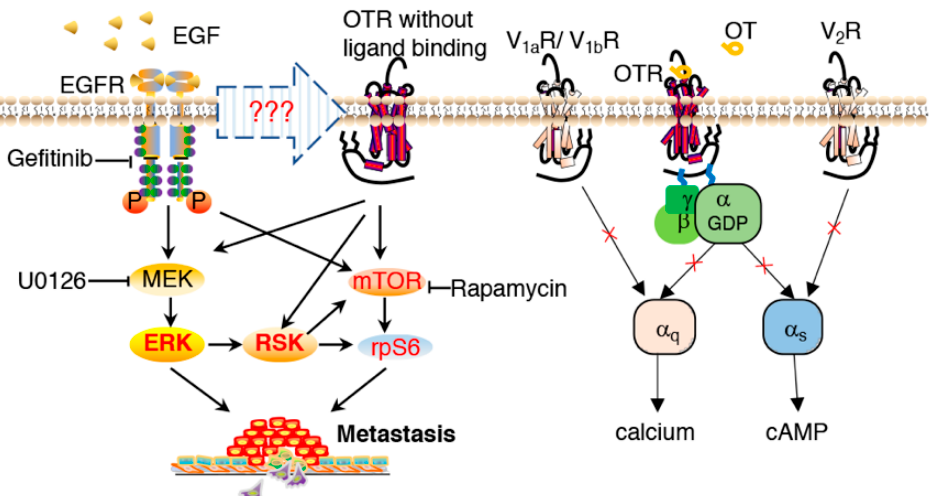
Figure 6. EGF ‐ mediated signal transduction involving the oxytocin receptor in promoting metasta ‐ Figure 6. EGF-mediated signal transduction involving the oxytocin receptor in promoting metas- sis. Normal OT/OTR signalling via G q or G s was compromised in MDA ‐ MB ‐ 231 cells. Involvement tasis. Normal OT/OTR signalling via G q or G s was compromised in MDA-MB-231 cells. Involve- of the V 1a R/V 1b R ‐ mediated G q pathway and V 2 R ‐ mediated G s pathway were excluded. In OTR ‐ over ‐ ment of the V 1a R/V 1b R-mediated G q pathway and V 2 R-mediated G s pathway were excluded. In expressing MDA ‐ MB ‐ 231 cells, EGF induced ERK1/2 ‐ RSK activation via both EGFR and OTR. The OTR-overexpressing MDA-MB-231 cells, EGF induced ERK1/2-RSK activation via both EGFR and mTOR pathway was also involved in EGF ‐ stimulated rpS6 activation, independent of ERK1/2 acti ‐ OTR. The mTOR pathway was also involved in EGF-stimulated rpS6 activation, independent of vation. ERK1/2